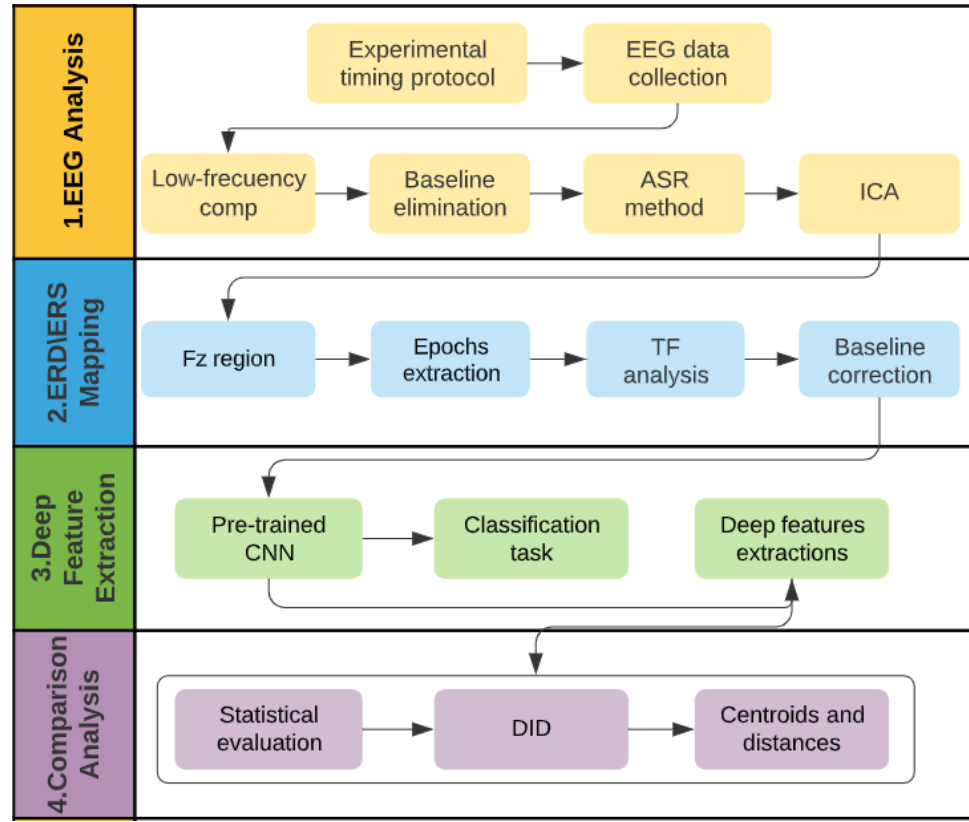
Figure 4. Pipeline of the EEG analysis to evaluate the effectiveness of ADT to treat subjective, chronic, and refractory tinnitus.